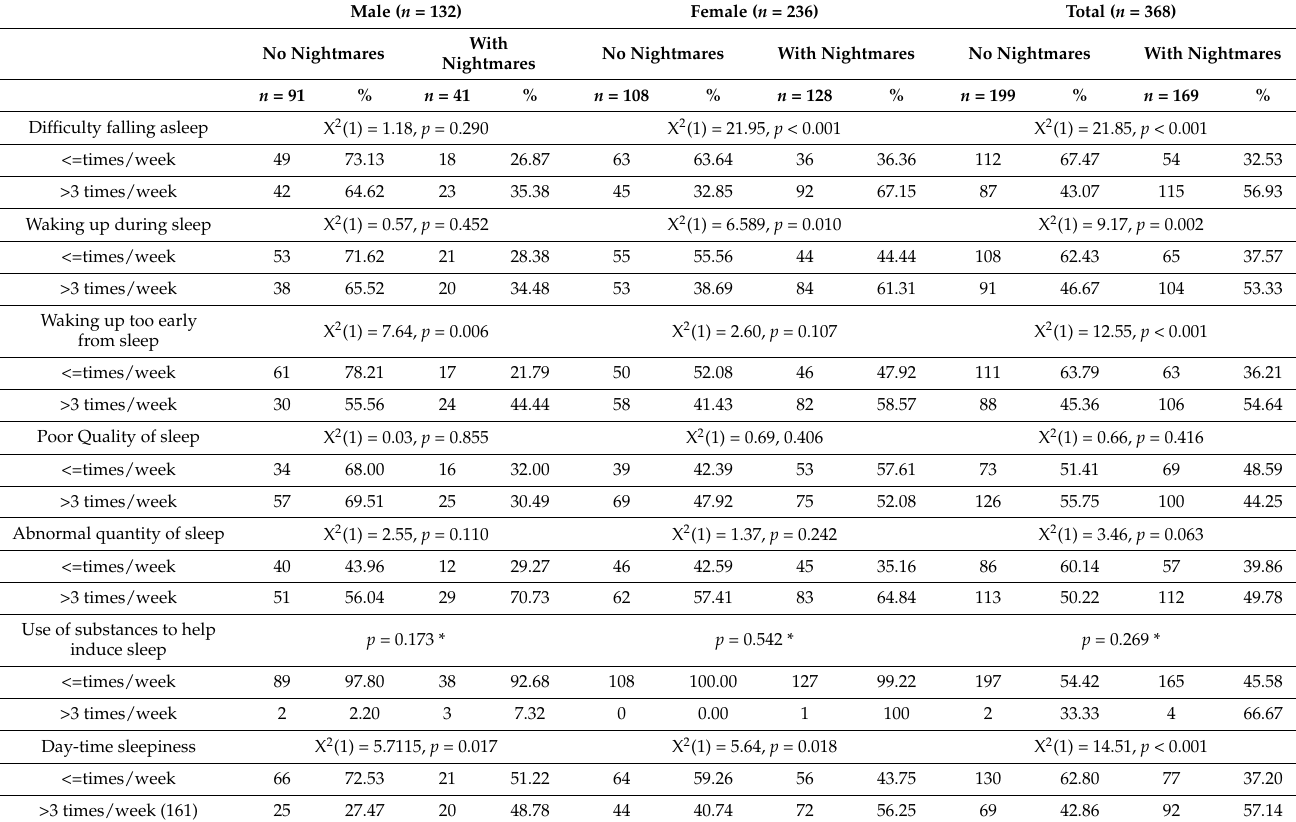
Table 3. Distribution of sleep disturbance components measured using GSDS concerning gender and presence of nightmares ( n =